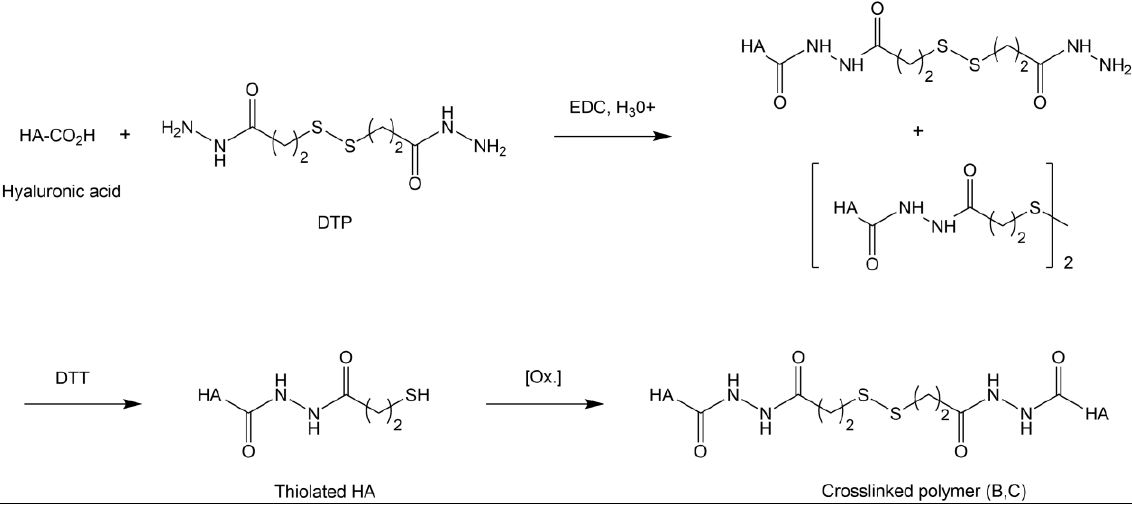
Figure 3. Synthetic route of hyaluronic acid crosslinked polymers B and C (HyaRegen ® and MateRegen ®